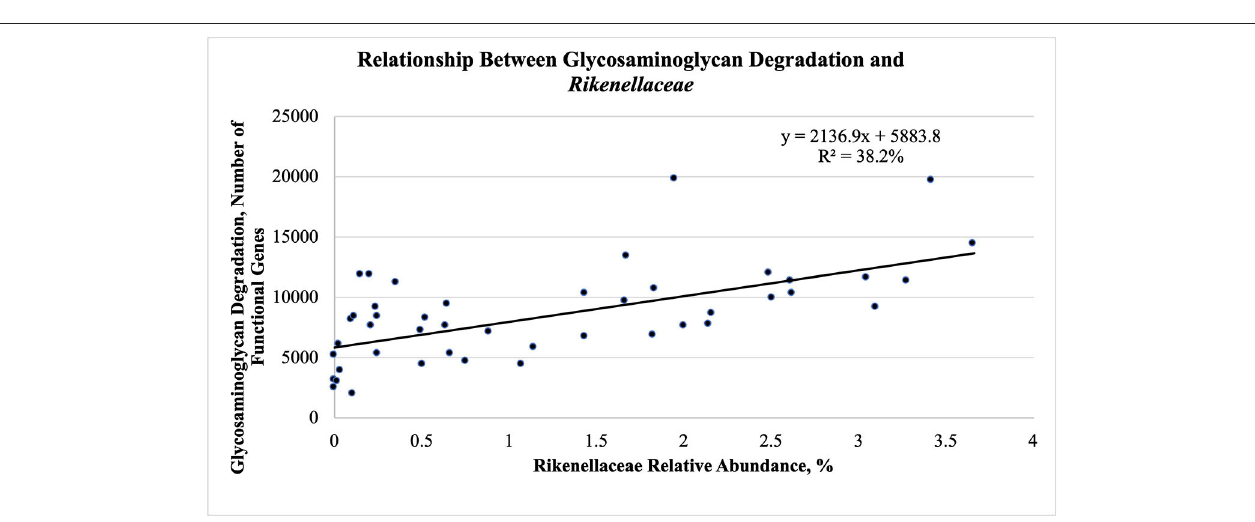
FIGURE 6 | Linear regression expressing the relationship between glycosaminoglycan degradation and Rikenellaceae abundance in the feces of Angus steers ( n = 15) across all stages of